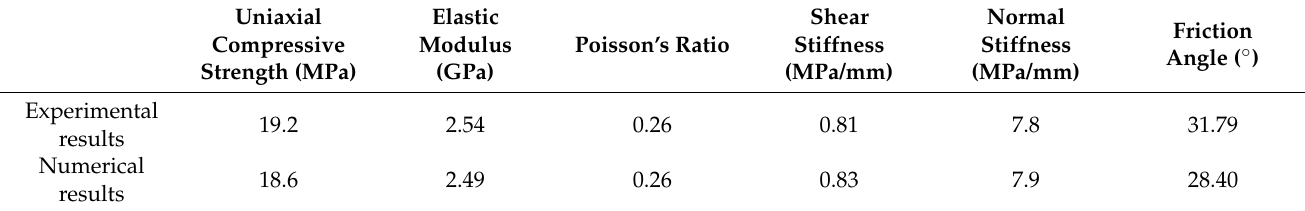
Figure 3. Numerical model for a 3D nonpersistent joint. Table 1. Results of laboratory experiments and numerical simulations.